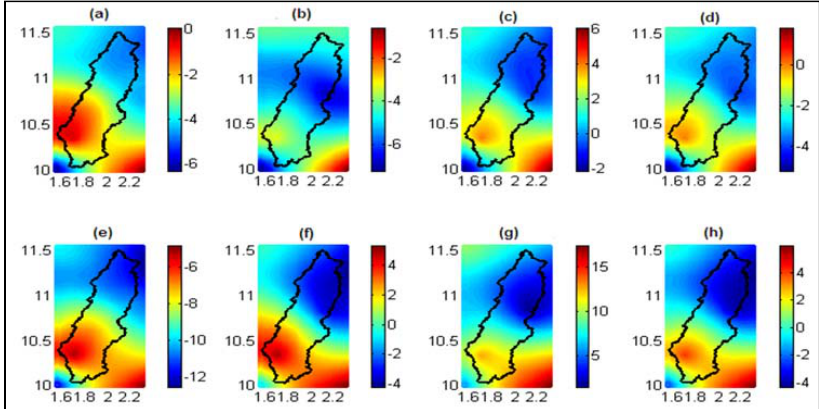
Figure 4. Changes in annual precipitation amounts (%) compared to the reference period: a : RCP4.5